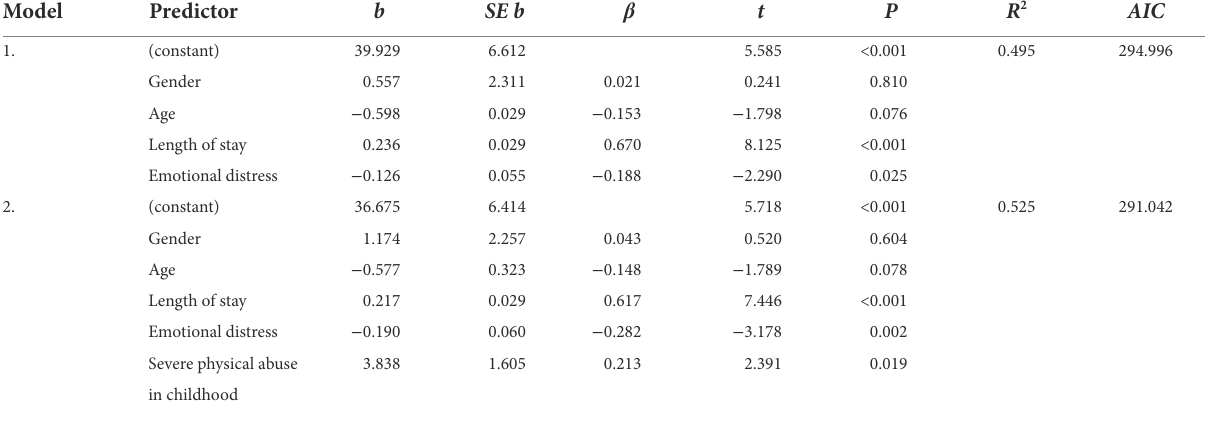
TABLE 3 Regression models of integration on gender, age, length of stay, emotional distress, and severe physical abuse in childhood.